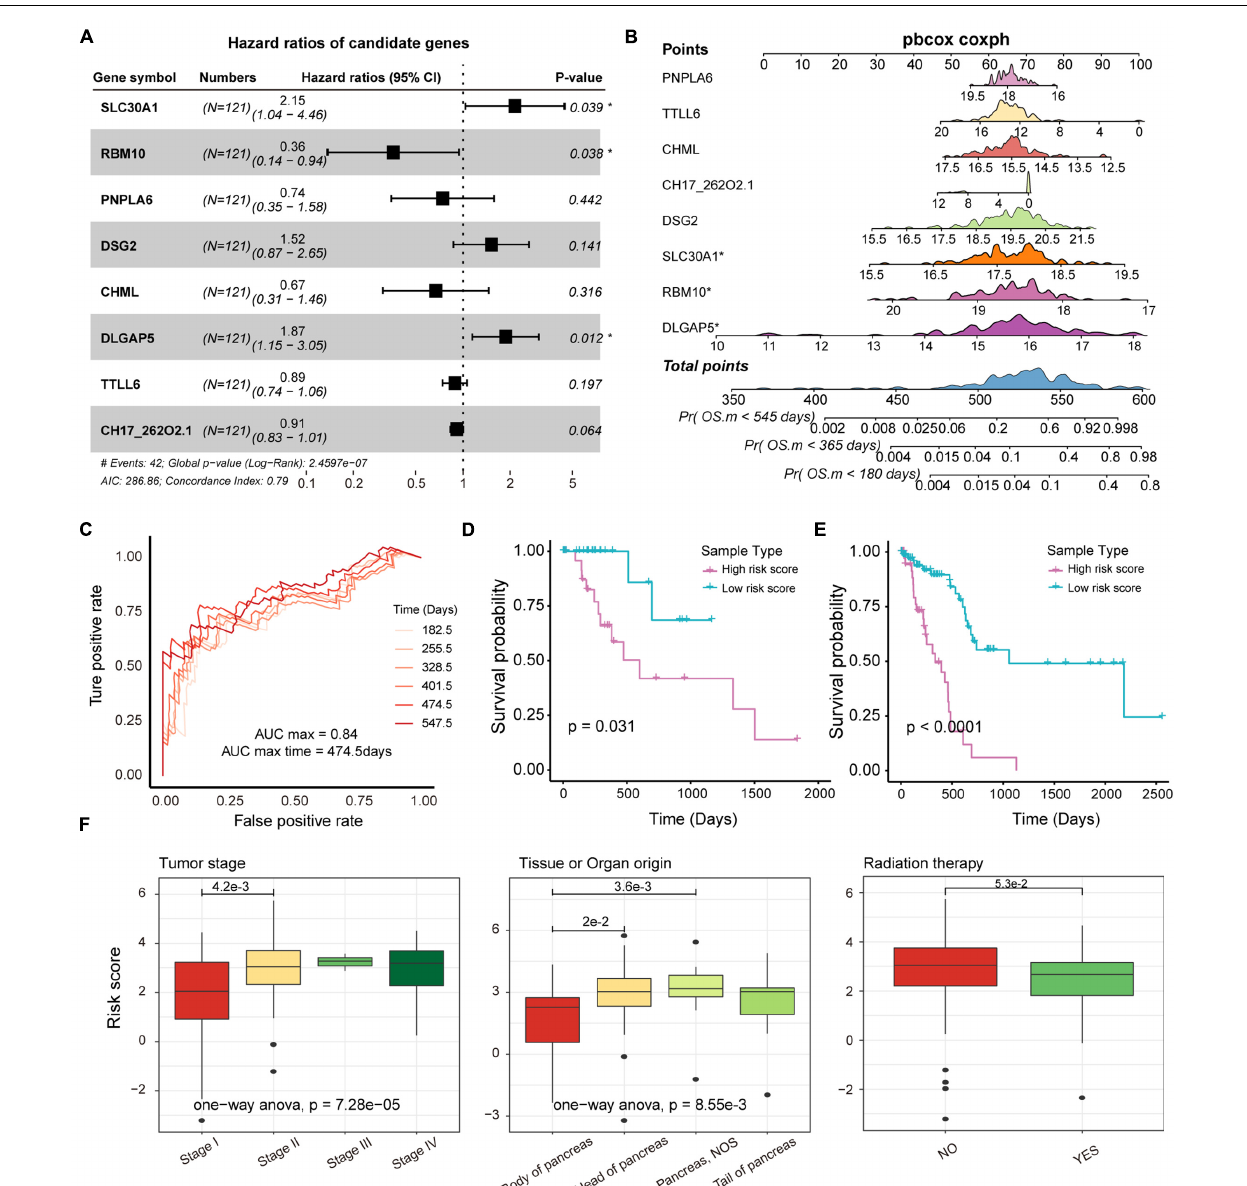
FIGURE 5 | Survival analysis of potential markers in PAAD. (A) Forest plots for multivariate Cox risk regression models. (B) Nomogram for survival risk prediction of 180, 365, and 545 days. The model contains eight features. (C) The ROC curve validation of the risk regression model at 6 time points. The different colored curves represent specific time-points. (D,E) KM plot of train and test dataset in which high- and low-risk groups were show as different lines. Log-rank test was used to calculate statistical significance. (F) Box plot of risk scores for samples of different tumor stages, tissue origin, and radiation therapy. The rank sum test and ANOVA were used to measure differences between